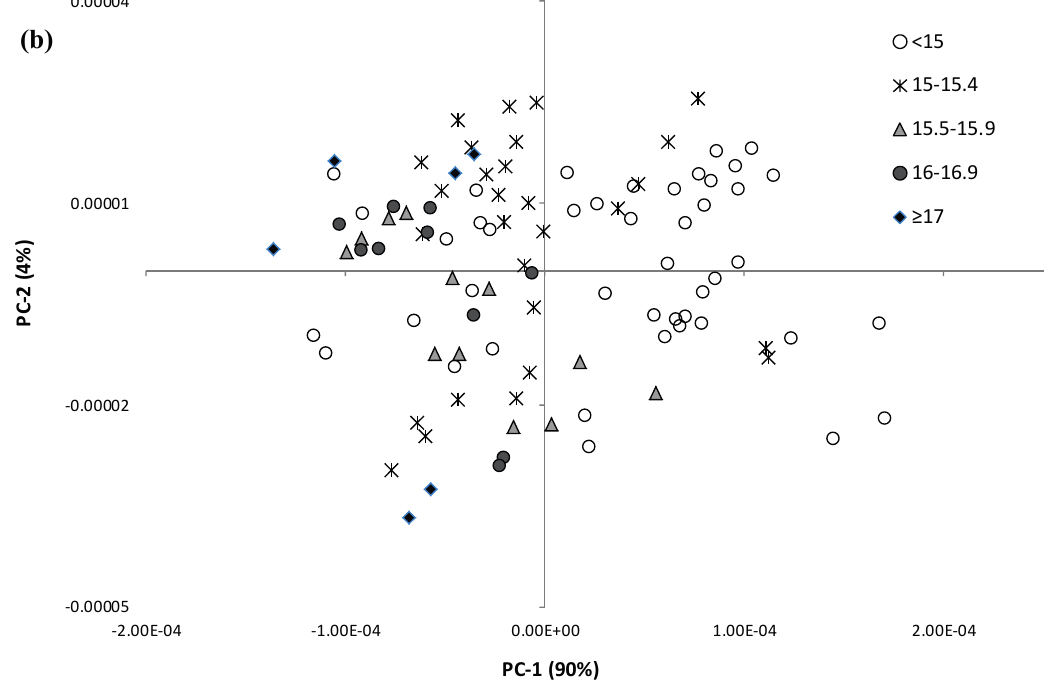
Figure 4. Score plots of the first two PC’s derived from the ‘fingerprint’ region (1500–900 cm − 1 ) of MIR spectra from (degassed) sparkling white wines, labelled by ( a ) production method, CA = carbonated ( n = 10), CH = Charmat ( n = 10), MT = Methodé Traditionelle ( n = 20) and TR = Transfer ( n = 10); and by ( b ) quality scores. Sparkling wines located within the circled regions designated as A , B , C and D have sensory profiles displayed in Figure